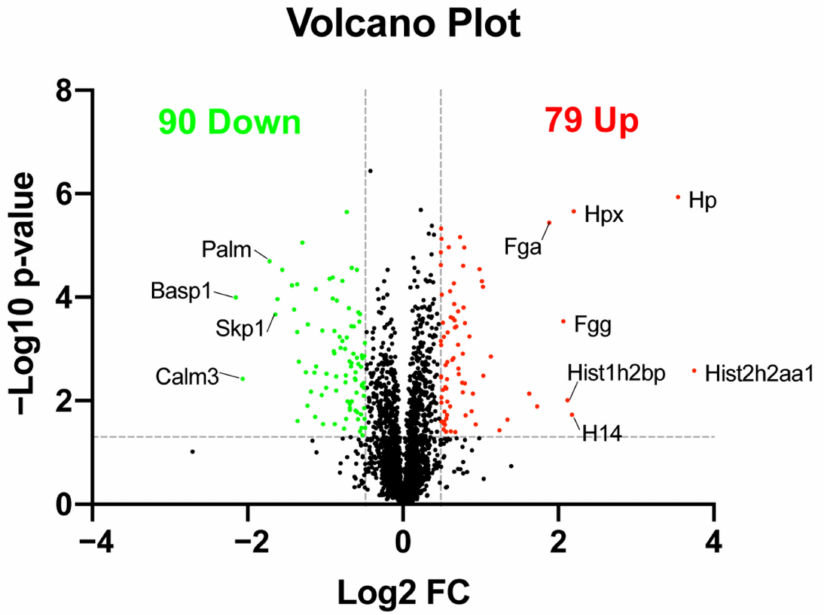
Figure 2. A volcano plot created in GraphPad Prism showing the comparison of DEPs between the treated and control groups. The differential expression was determined as fold-change ratio (LPS/PBS) > 1.4 or < − 1.4, p < 0.05, unpaired t -test. Each point represents a protein. Red dots represent upregulated proteins and green dots represent downregulated